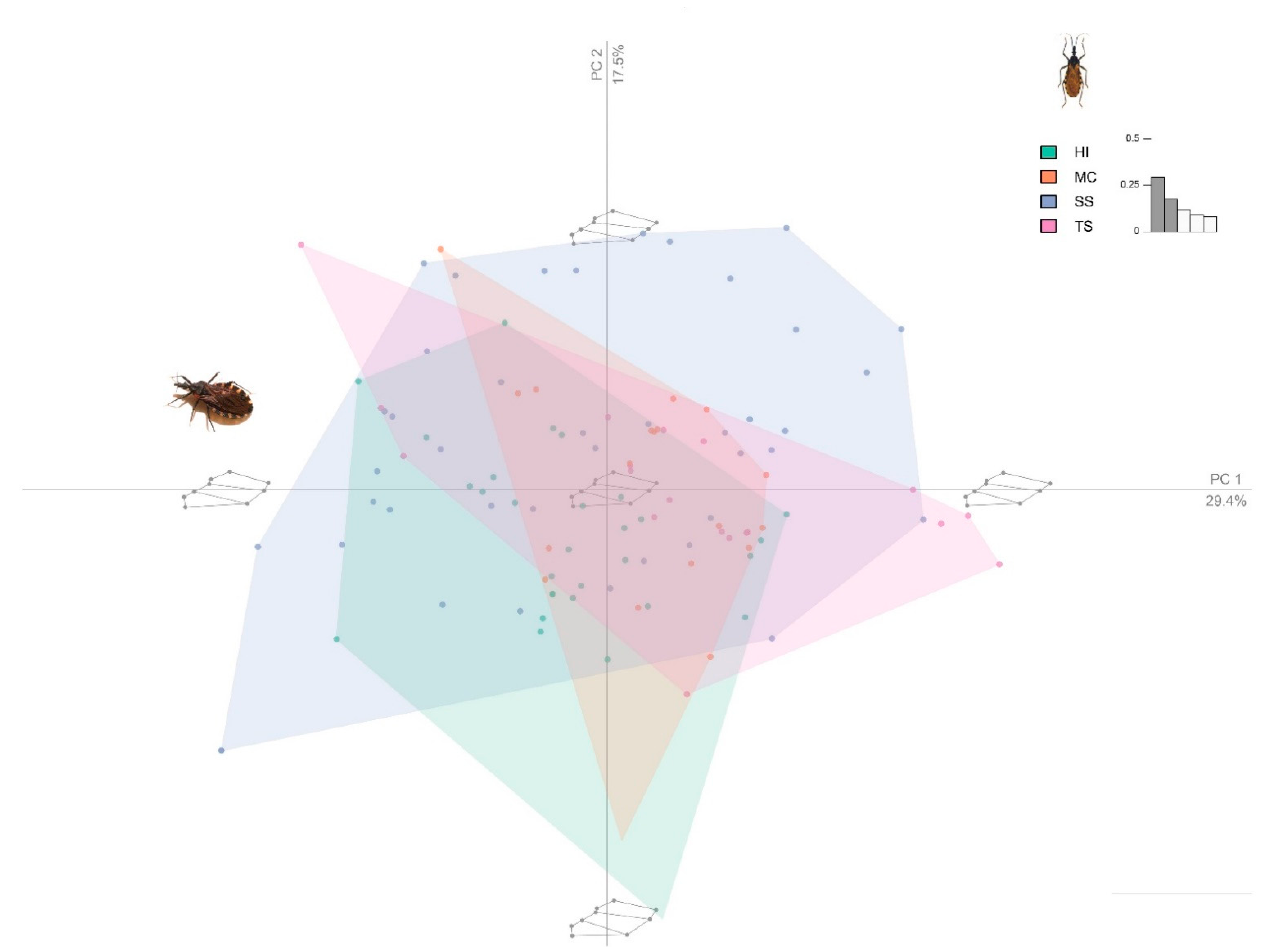
Figure 4. Principal component analysis (PCA) of the Triatoma infestans wing view in four populations. Color code: green: Huacaya/Imbochi (HI); orange: Monteagudo/Cañon Largo (MC); blue: Sucre/Surima SS), and pink: Tarabuco/Sarufaya (TS).